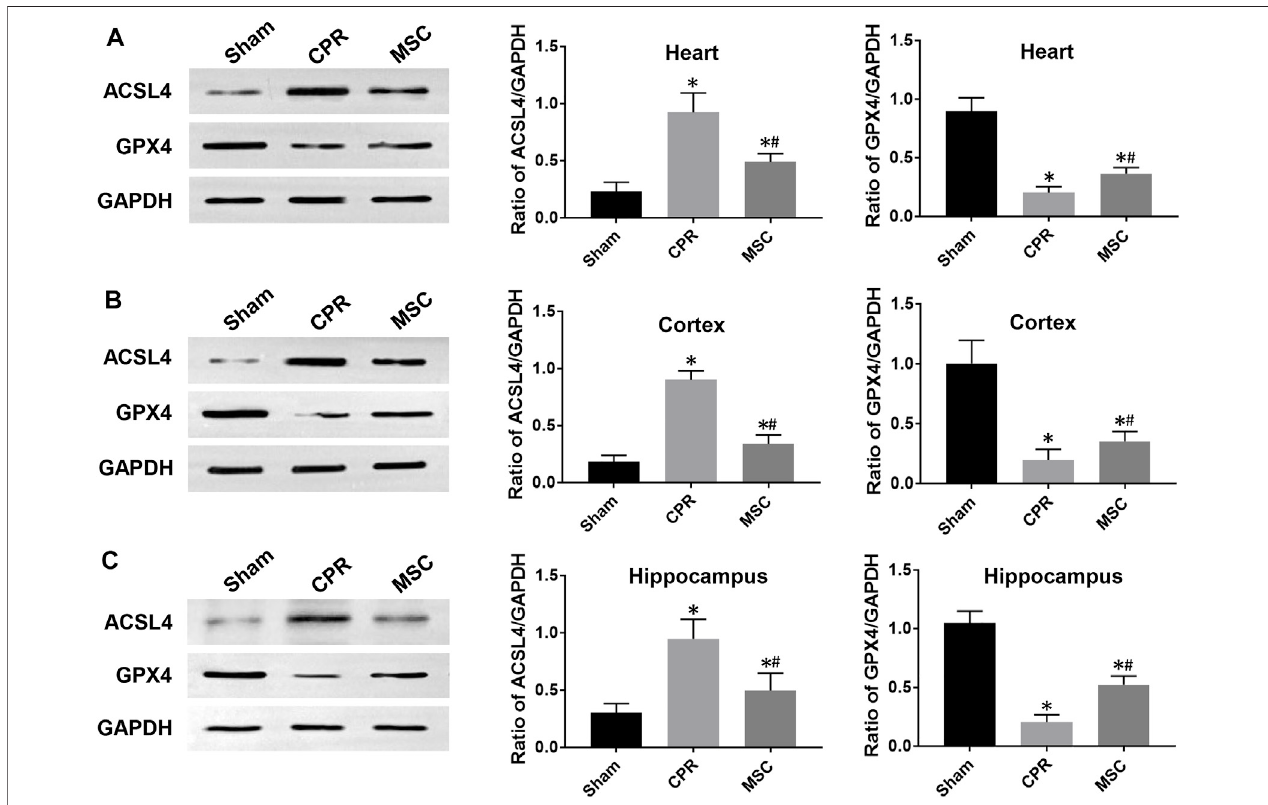
FIGURE 8 | Expression of ferroptosis-related proteins (A) – (C) The expression levels of ACSL4 and GPX4 in the heart, cortex and hippocampus.ACSL4, acyl-CoA synthetase long-chain family member 4; GPX4, glutathione peroxidase 4; CPR, cardiopulmonary resuscitation; MSC, mesenchymal stem cell. * p < 0.05 versus sham group; # p < 0.05 versus CPR